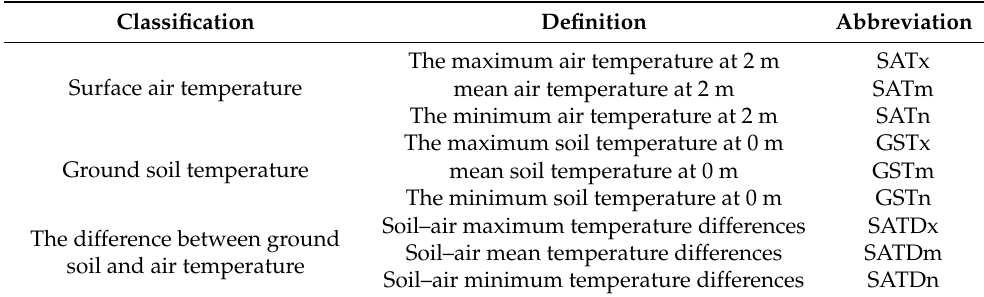
Table 1. The indexes of the ground soil temperature, surface air temperature and differences between ground soil and air temperature.